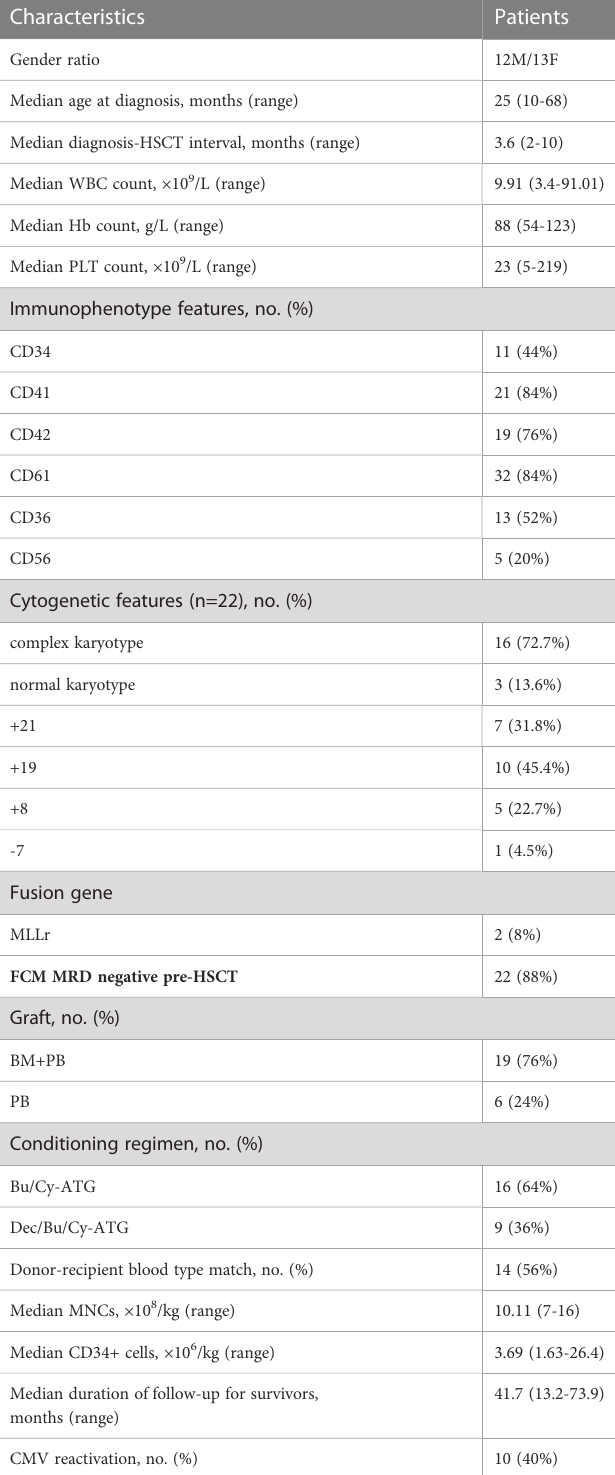
TABLE 1 Characteristics of pediatric AMKL patients without DS undergoing haplo-transplant